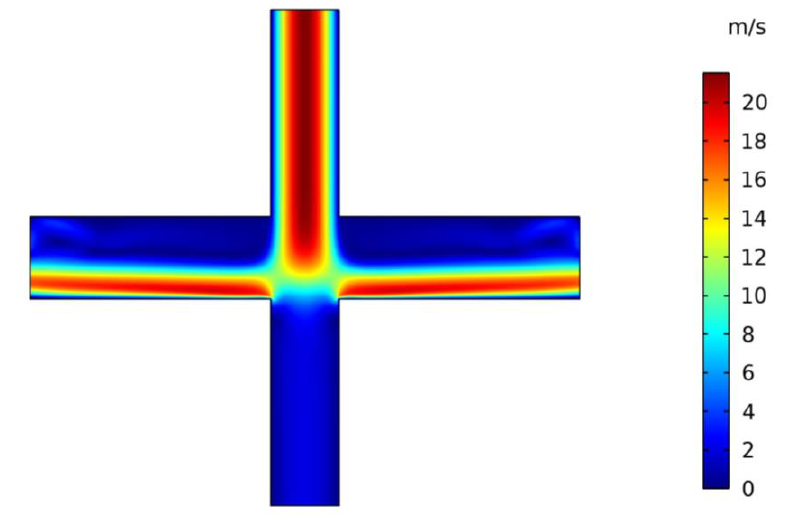
Figure 4. Velocity distribution in VI.